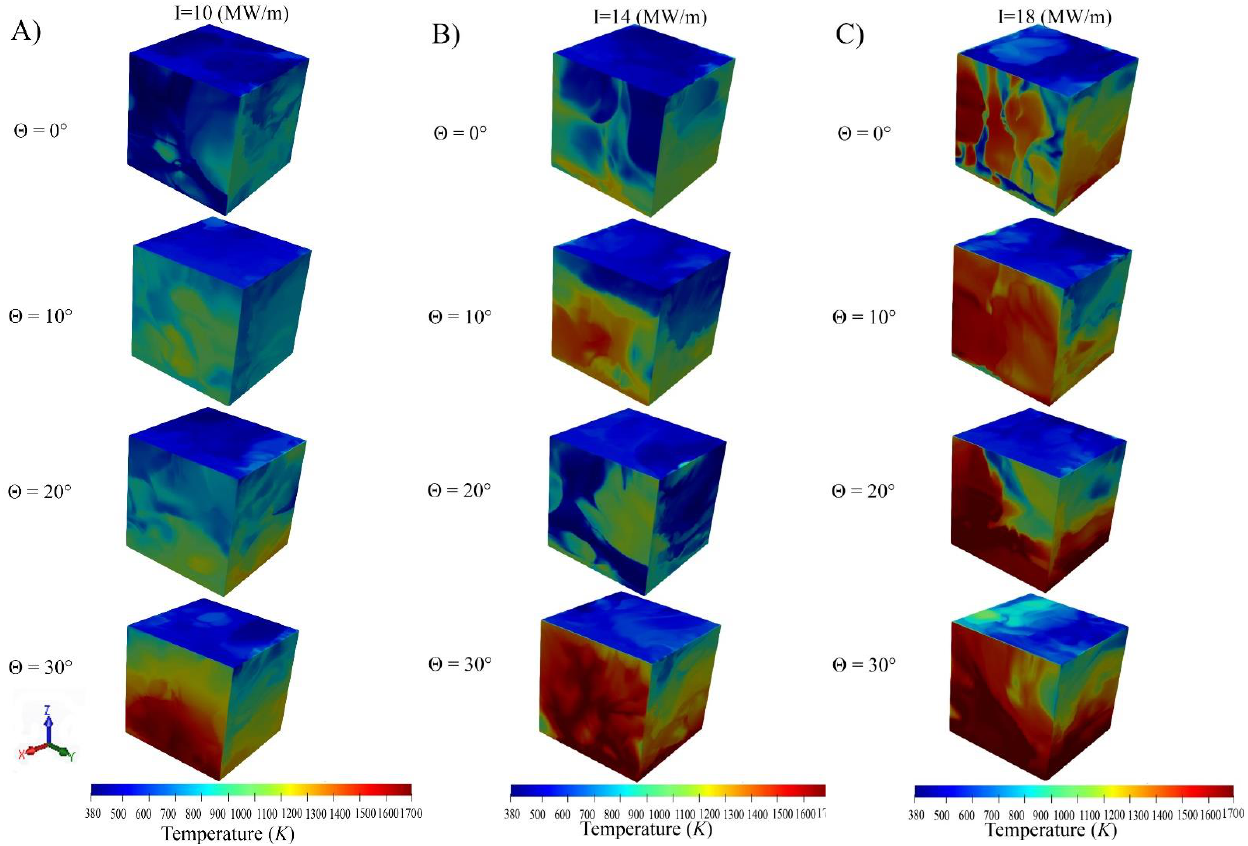
Figure 6. The time-averaged plot of the temperature distribution on the surface of the building for three different fire intensity values and terrain slope at the stabilized state of the flame ( A ) Fire intensity of 10 (I = 10 MW/m), ( B ) Fire intensity of 14 (I = 14 MW/m) and ( C ) Fire intensity of 18 (I = 18 MW/m).